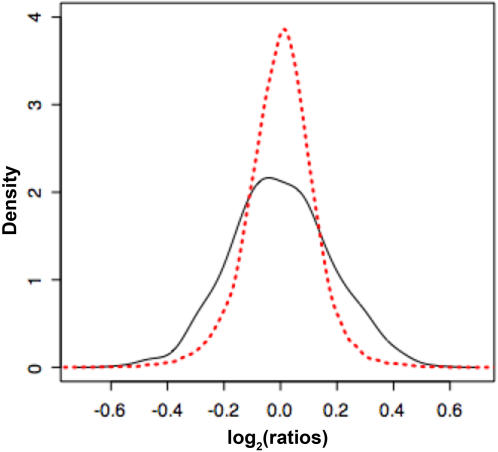
Exercise is more likely to affect “aging” genes than genes not associated with age.The x-axis (log2) represents the ratio of post over pre-exercise gene expression among older subjects. The dark solid line represents the distribution of log2 ratios of exercise (post/pre) among genes that are significantly associated with age. The red line represents the equivalent distribution for those genes not associated with aging. The p-value associated with the difference in distributions is less than 0.0001.